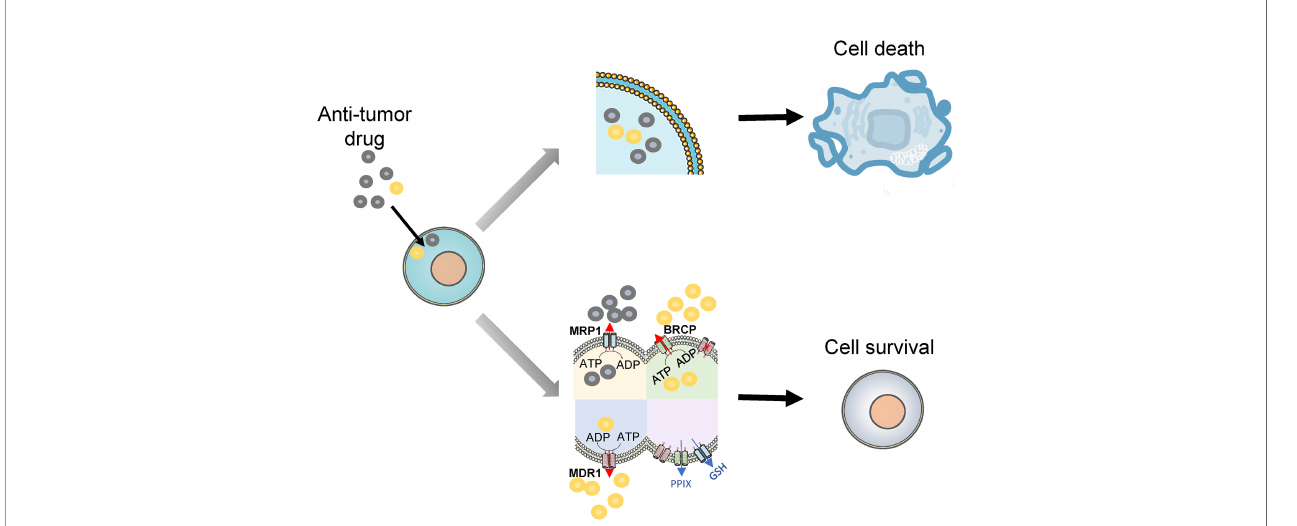
FIGURE 3 | Drug ef fl ux and drug resistance. Multiple anti-tumor drugs enter to kill leukemia cells (upper part), but LSCs upregulate ABC transporters to ef fl ux drugs to overcome the cytotoxic effects of multiple chemotherapeutic drugs, even single blocking of MDR1 does not signi fi cantly improve chemotherapy